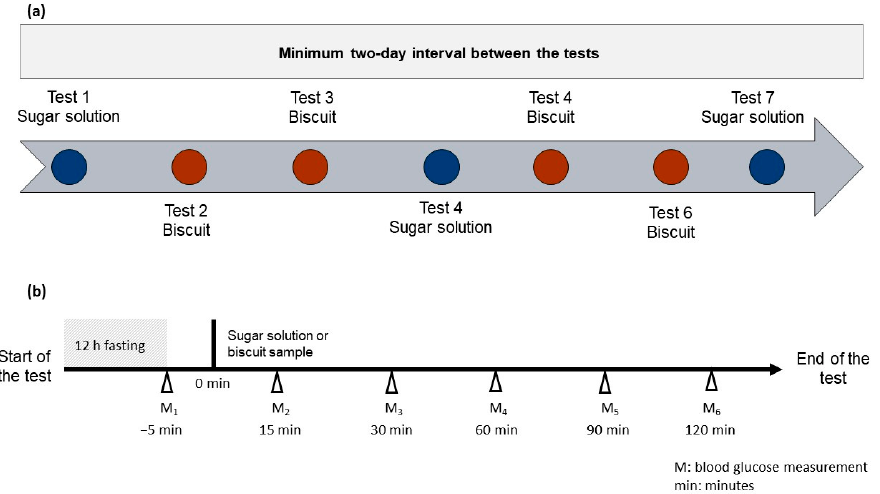
Figure 2. A schematic overview of the seven tests ( a ) and the accompanied visual instruction for performing the test ( b ).